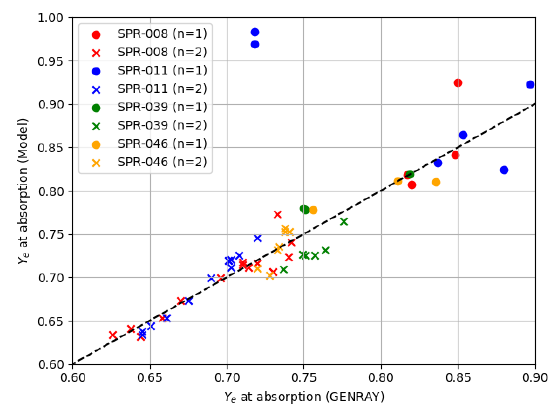
Figure 7. Predicted Y value at absorption using α = 3.35 (y axis) vs value from GENRAY, for rays giving optimal current drive. The dashed black line is y=x. There is reasonable agreement with a mean absolute error of 0.02.